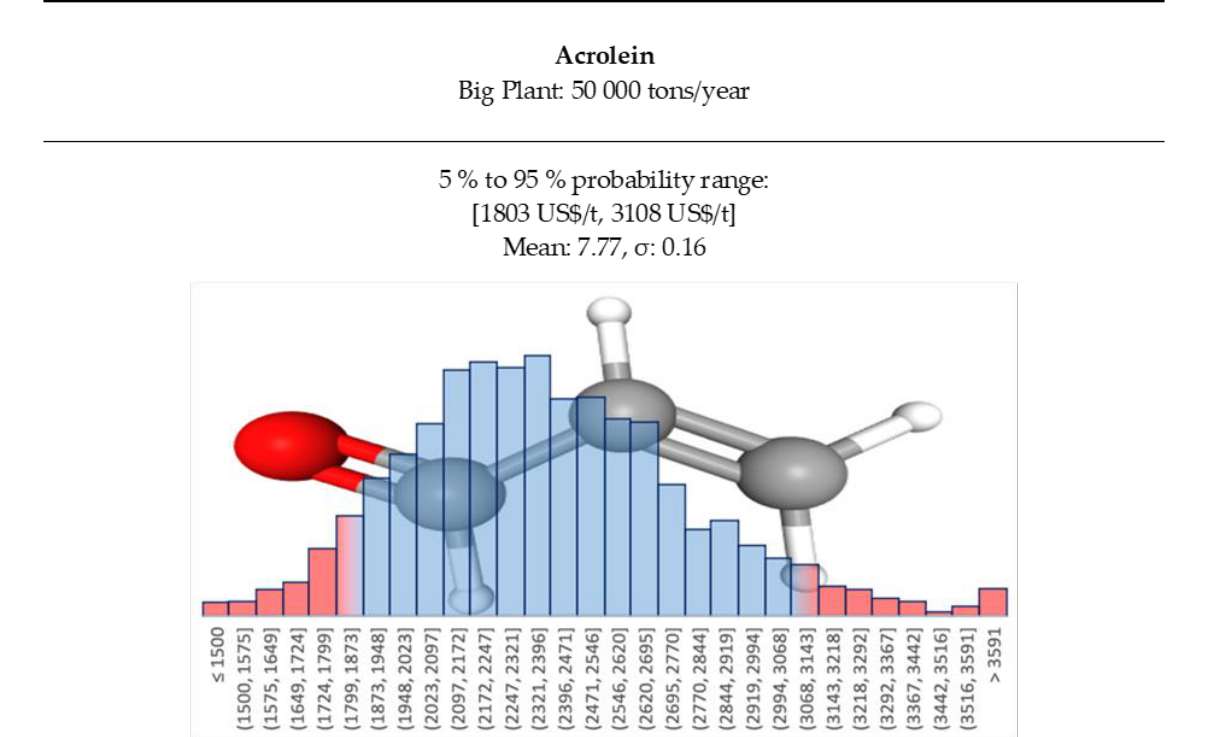
Figure 12. Acrolein price log-normal distributions for the big plant case.